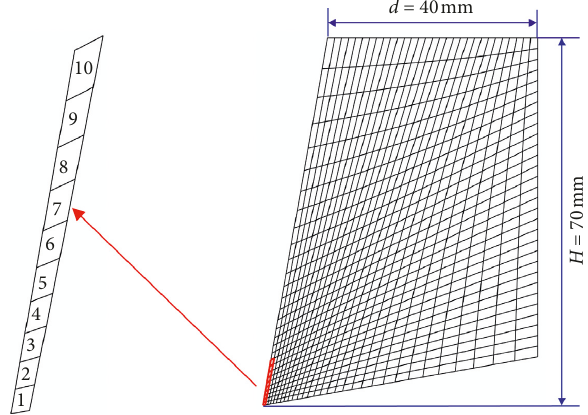
Figure 4: Schematic diagram of main contact elements on the rack face.